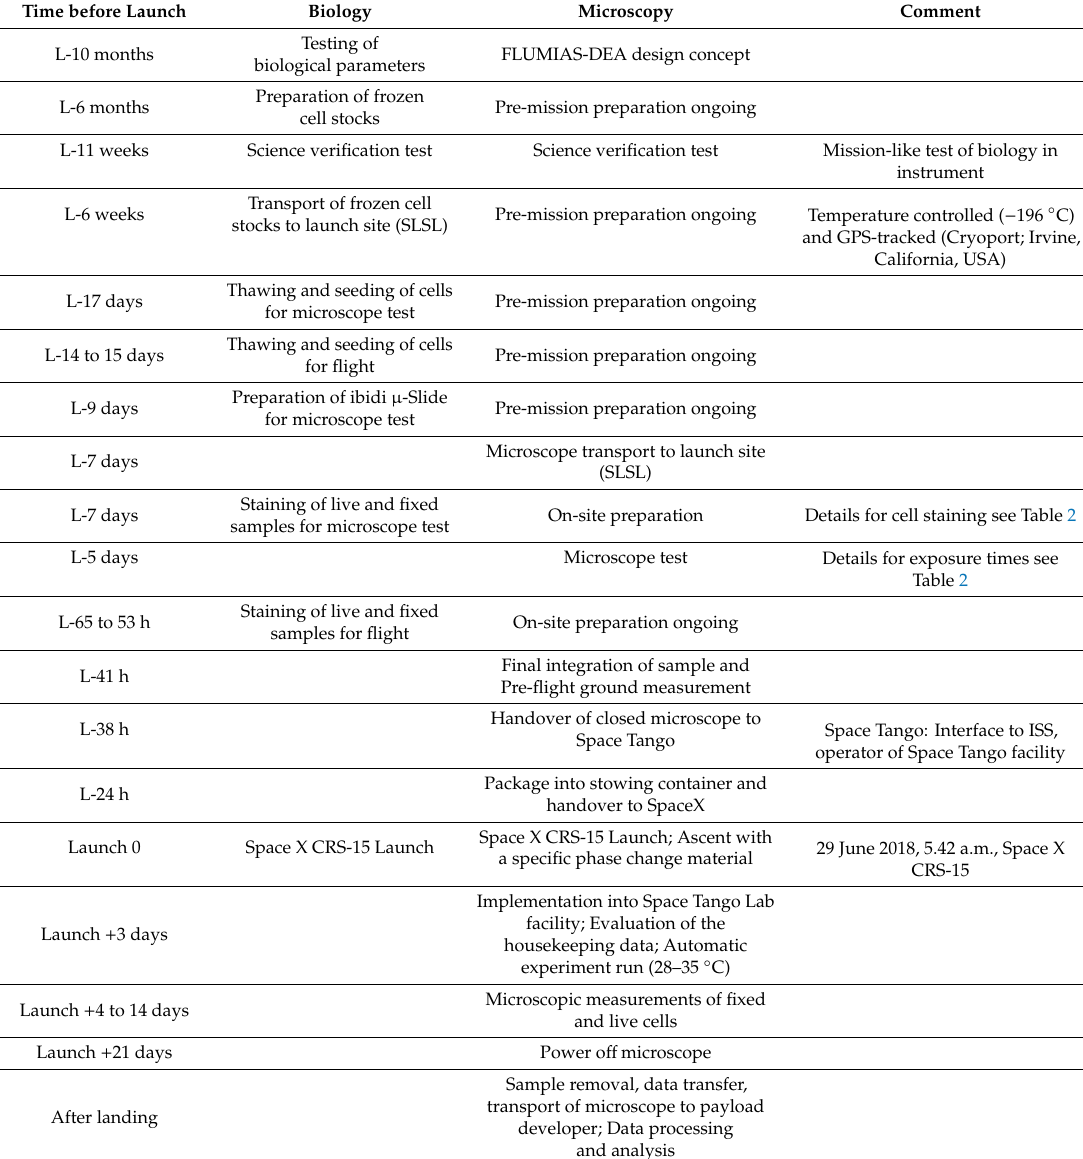
Table 3. Sample preparation procedure for a (live) cell microscopy-experiment on board the ISS using the FLUMIAS-DEA microscope. L: